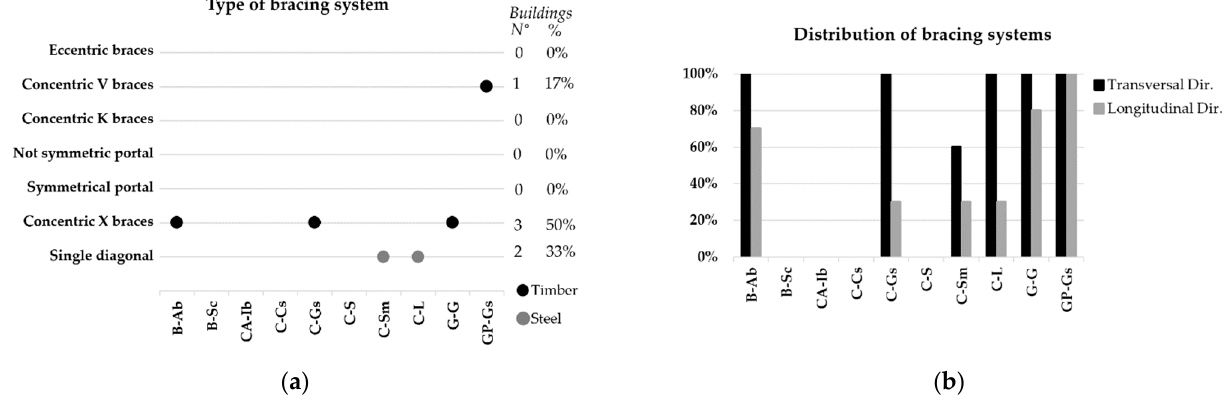
Figure 23. Section 3D CARTIS-Districts. Characterization of timber type: ( a ) Type and ( b ) Distribution of bracing systems.